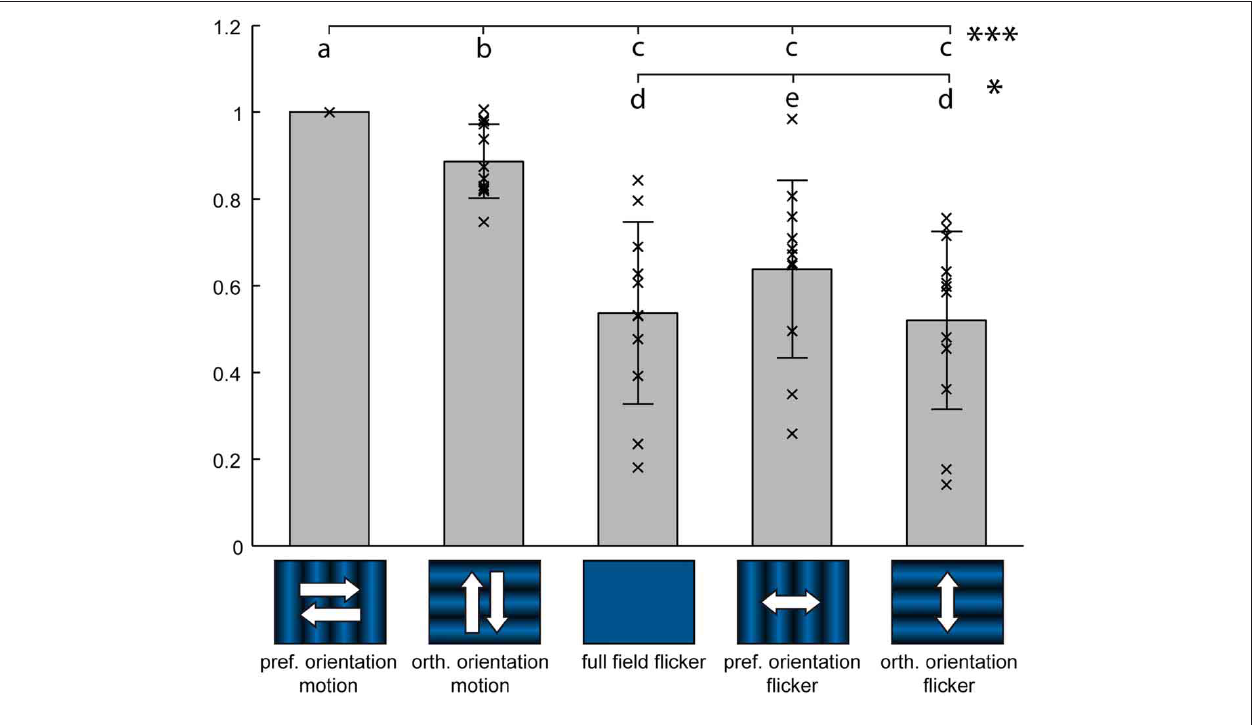
FIGURE 5 | Flicker stimuli elicit weaker responses than motion. Response of 12 medulla cell populations during stimulation with two orthogonal orientations of motion, full-field flicker, and two corresponding orientations of counter-phase flicker. Each data point represents average responses from one staining and 2–3 trials, from a circular Region of Interest